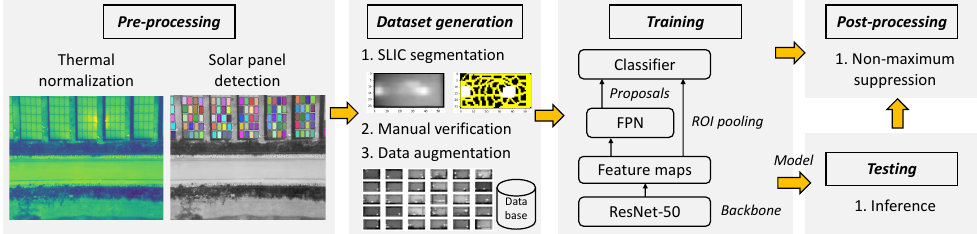
Figure 7. The workflow of our anomaly detection algorithm based on thermal images. In the pre- processing phase, the thermal images are normalized and the solar panels are detected. The latter are fed to SLIC segmentation to generate positive samples of hotspots. These are manually checked and the dataset is augmented using several operations (rotations, crops, contrast, etc.). Training is based on a region-based CNN, using a Feature Pyramid Network (FPN) as region proposal network and a ResNet-50 as backbone. Finally, post-processing comprises non-maximum suppression to filter out ‘duplicate’ (i.e., overlapping)